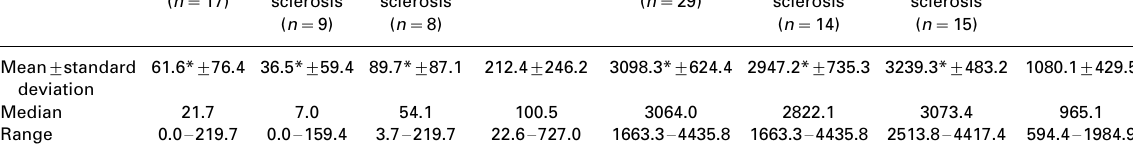
Control group (n (cid:3) / 10)